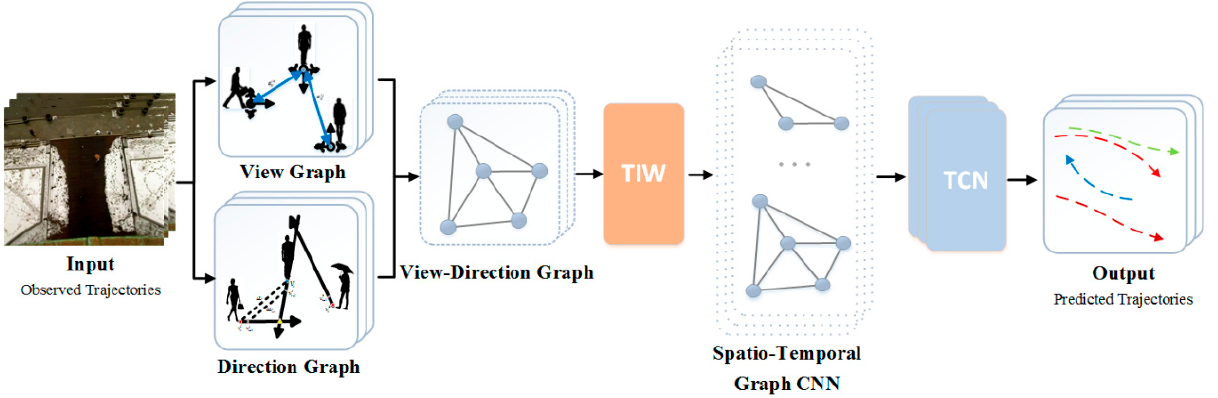
Figure 6. The framework of the trajectory prediction model based on a prior awareness and information fusion, where TIW indicates the weighting module of temporal information, and the spatio-temporal Graph CNN contains the spatial interaction module of multi-pedestrians (M-PSI) that we proposed.